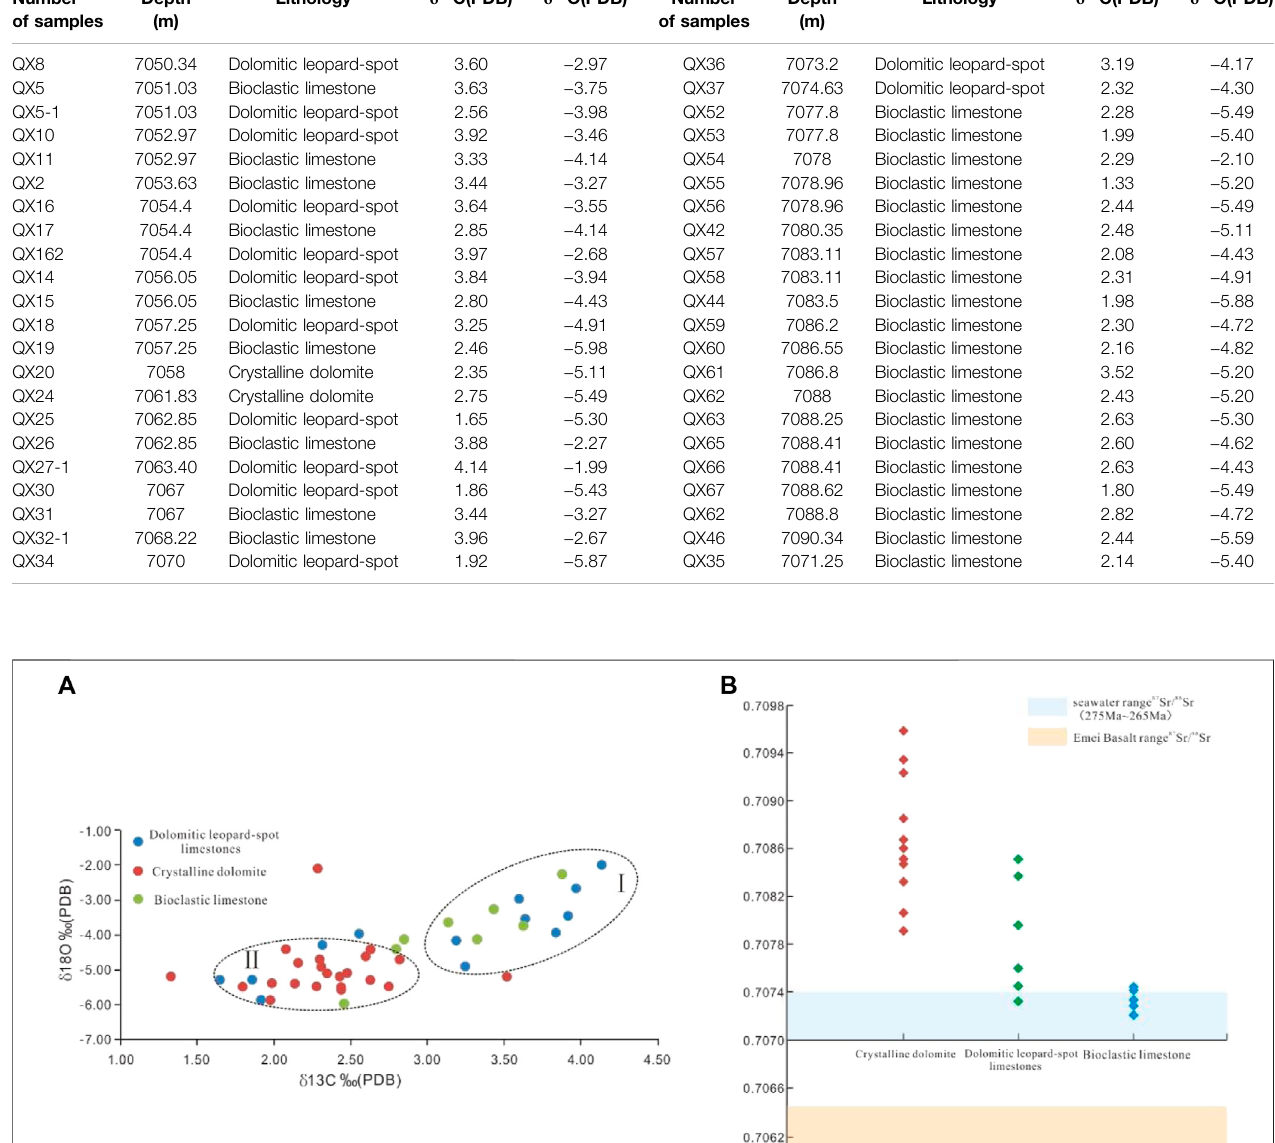
TABLE 1 | C and O isotope data of carbonates in Qixia Formation of ST12 in the study area. Number of samples